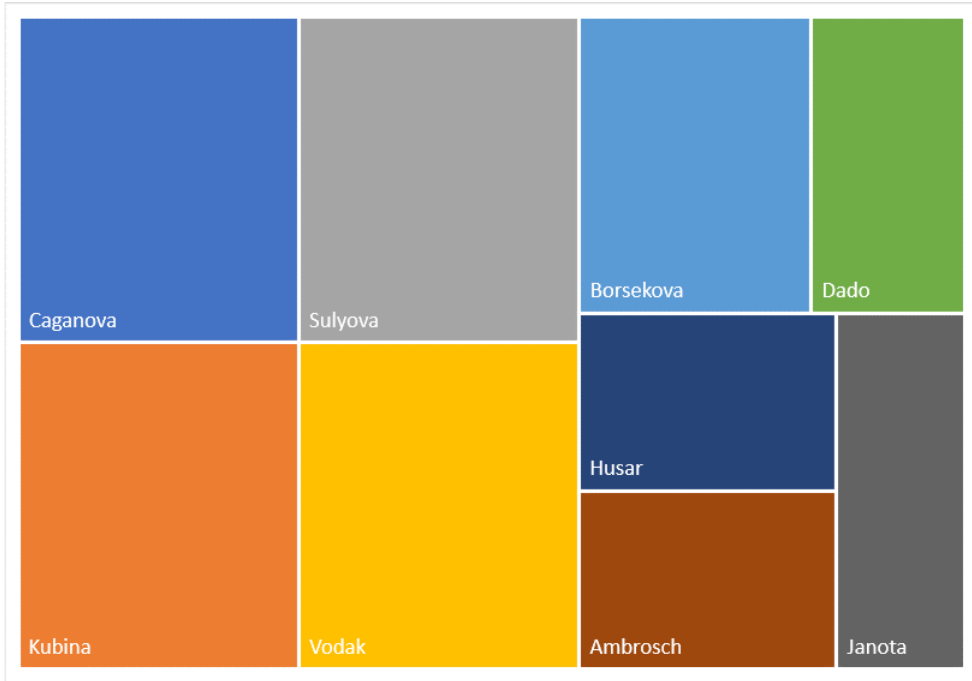
Figure 9. An overview of Slovak authors publishing on the topic of Smart cities. Source: own analysis as per Web of Science (2022).